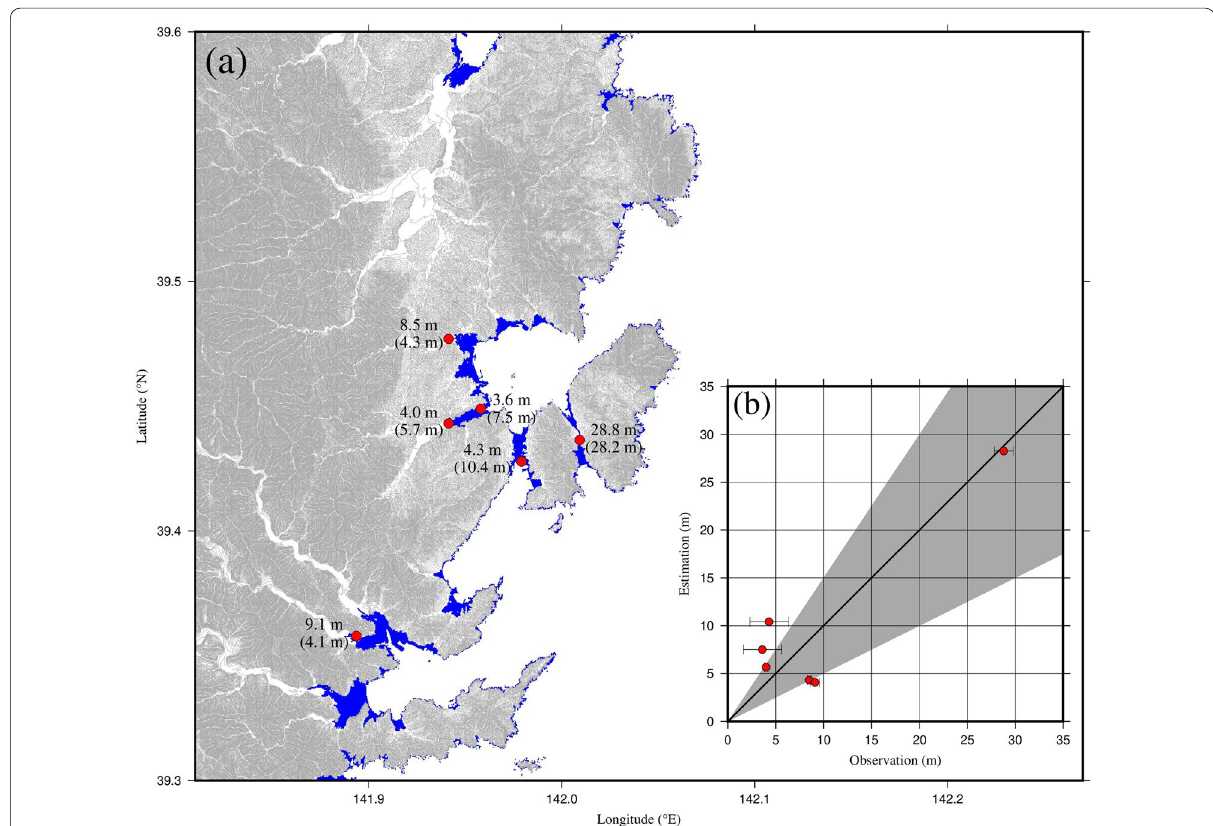
Fig. 8 Simulated inundation area (blue) under the scenario with sources N and S, and a comparison of the simulated heights and observations. The simulated heights are displayed to follow the observed values from the observation sites (red circle) in ( a ). The magnitude of the error in ( b ) is the one shown in Ebina and Imai (2014), and the gray area indicates an error range within